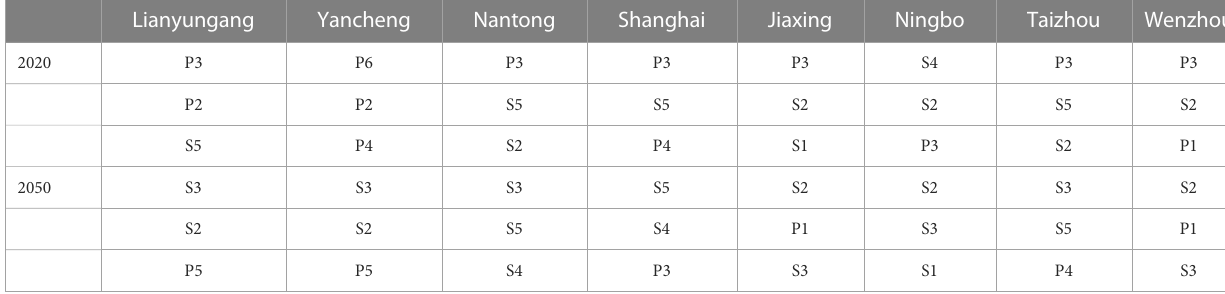
TABLE 7 Main obstacle factors of CRECC in Yangtze River Delta coastal